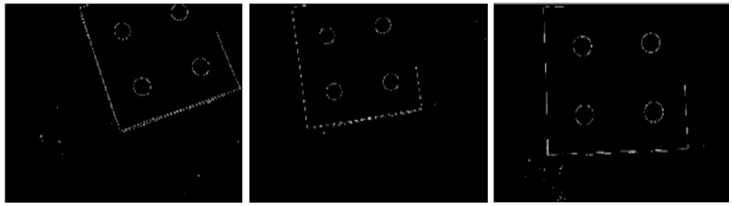
Figure 10. The feature extraction results of the convergence process.